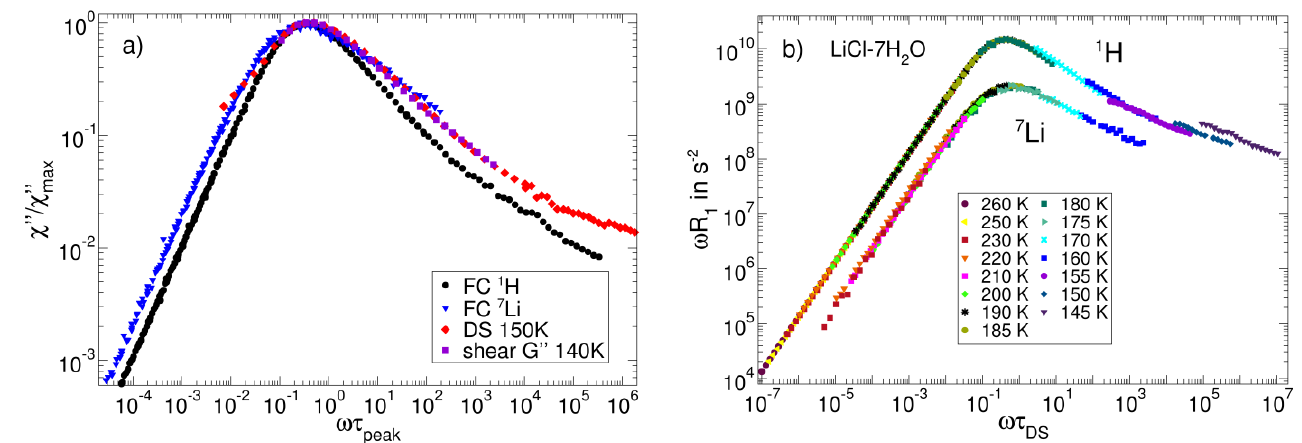
Figure 8. ( a ) Field-cycling 1 H and 7 Li susceptibilities compared to DS and shear relaxation susceptibilities at 150 K and 140 K, respectively, plotted over a reduced frequency scale ωτ peak . The data are scaled by their maximum values. ( b ) ω R 1 ( T ) 1 H and 7 Li FC data, rescaled horizontally by the respective τ DS ( T ) from DS data [117]. Most FC data collapse onto a master curve. Deviations occur at low temperatures, where a secondary water process separates from the α -process